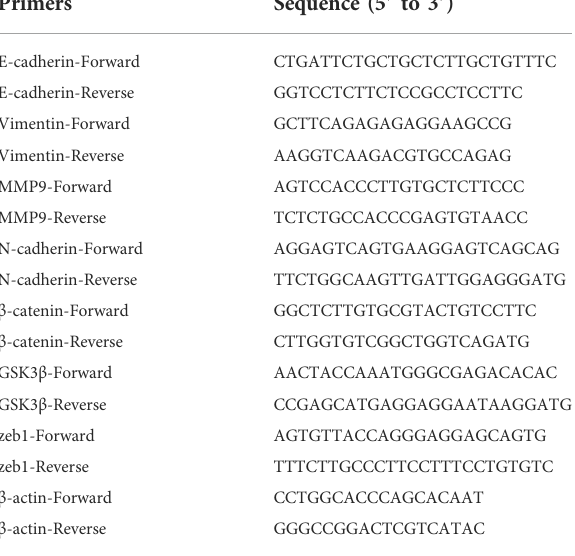
TABLE 1 Sequences of all